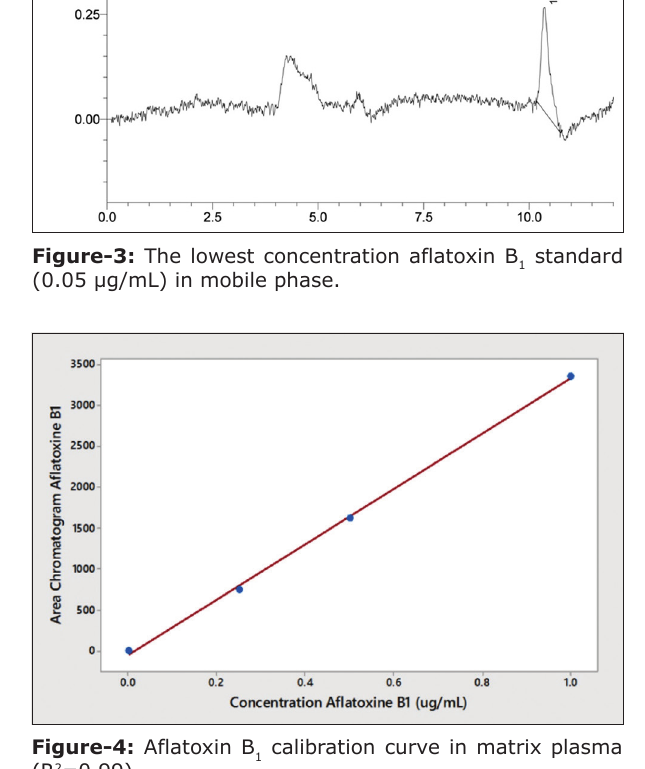
calibration curve in matrix plasma 1